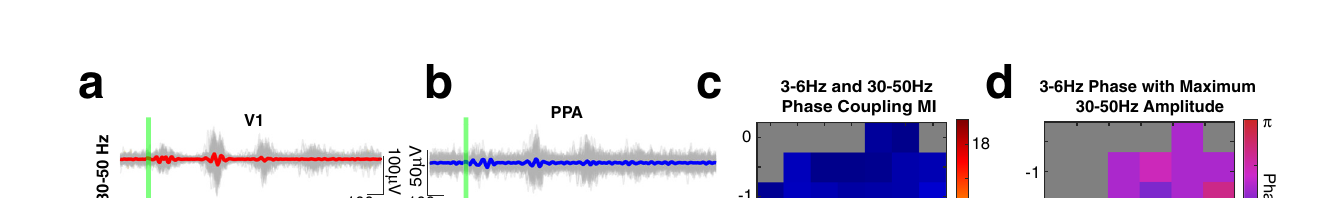
wavelengths of 30 – 50 and 3 – 6Hz most visually responsive modes. b Distribution of wave speeds of most visually responsive modes at 30 – 50 and 3 –